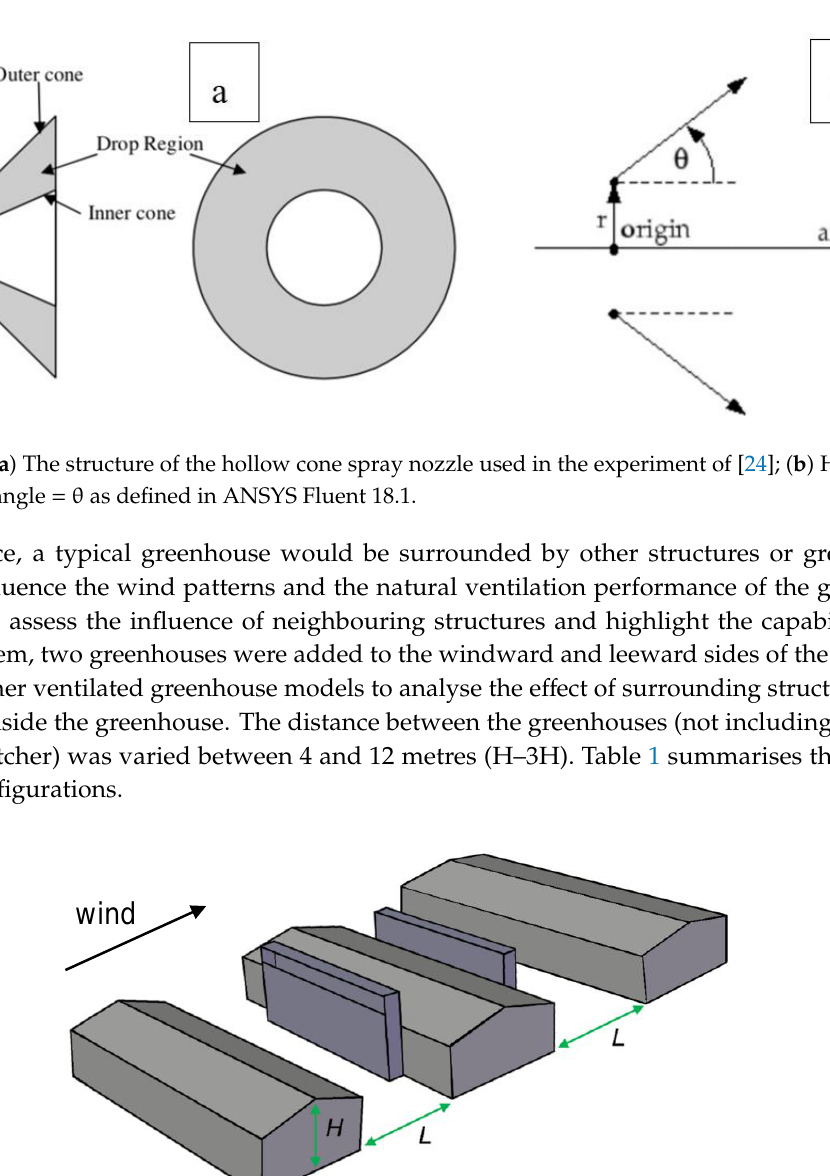
Figure 4. ( a ) Top view of the four jet spray nozzle layout; ( b ) Front view of the four jet spray nozzle parallel layout; ( c ) Front view of the four jet spray nozzle staggered layout.